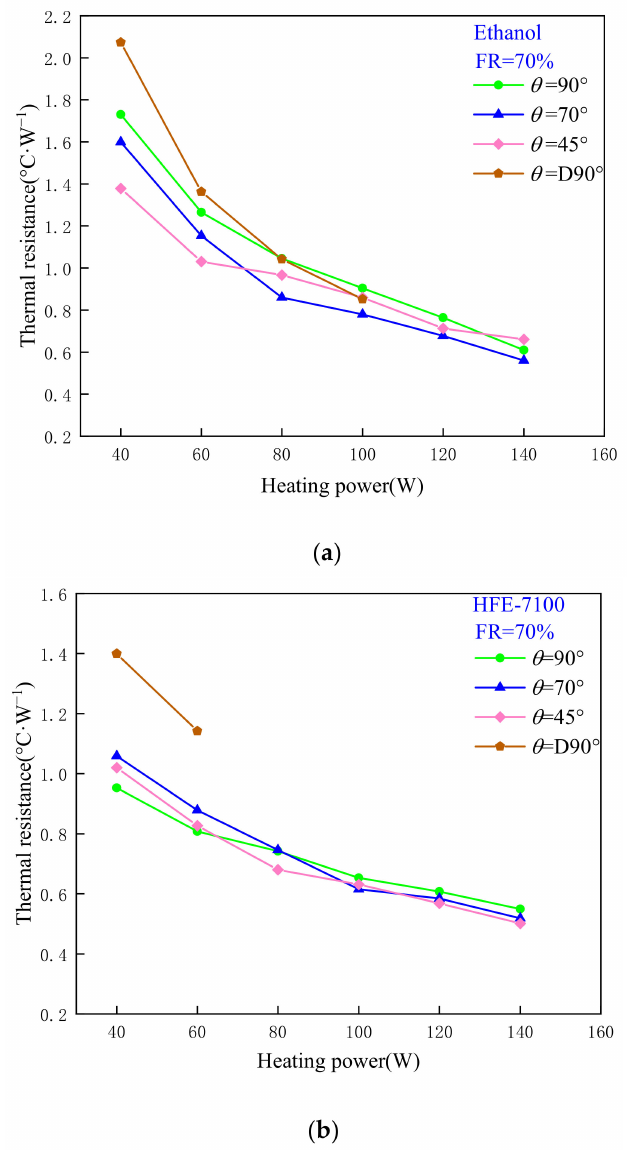
Figure 4. Variation of thermal resistance of pulsating heat pipe with installation angle under homo- geneous heat flux: ( a ) Ethanol ( b )